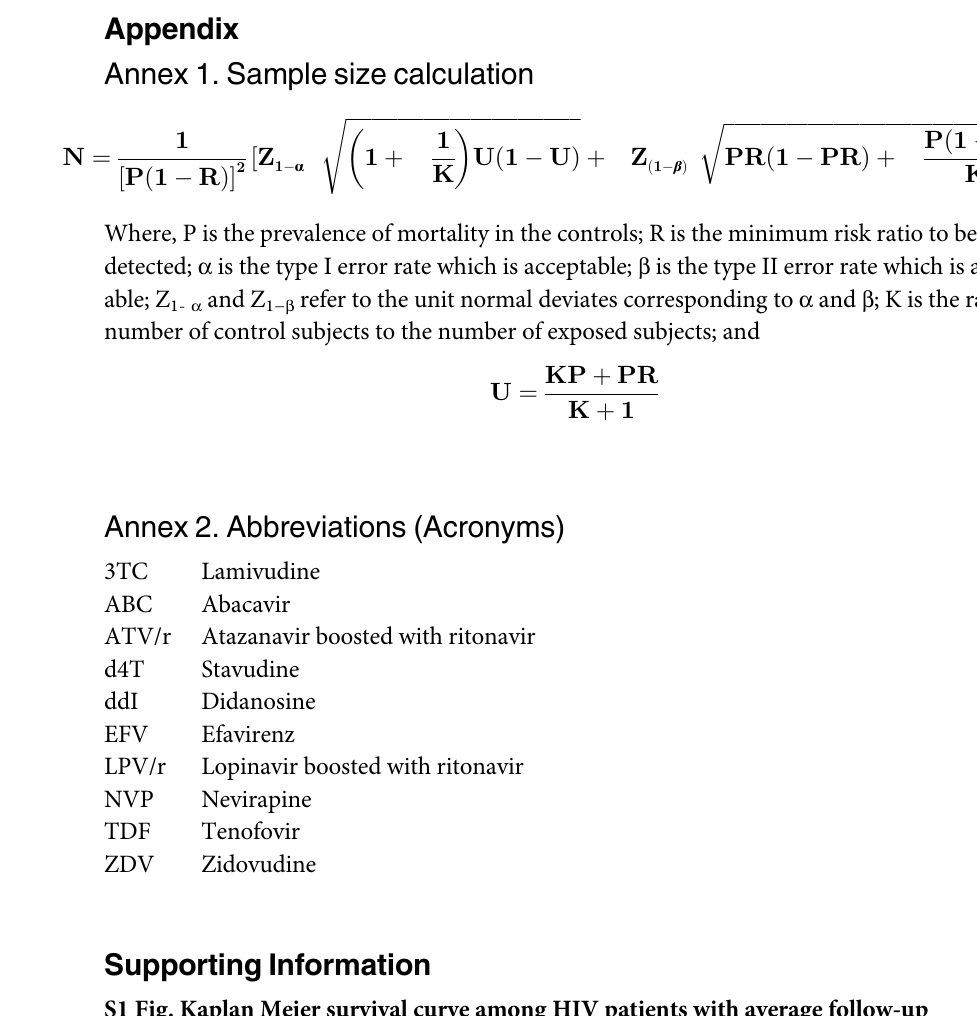
S1 Protocol. Individual patient data abstraction form for HIV-infected patients on IPT plus ART and ART alone versus effects on all-cause mortality, incident TB and HIV pro-